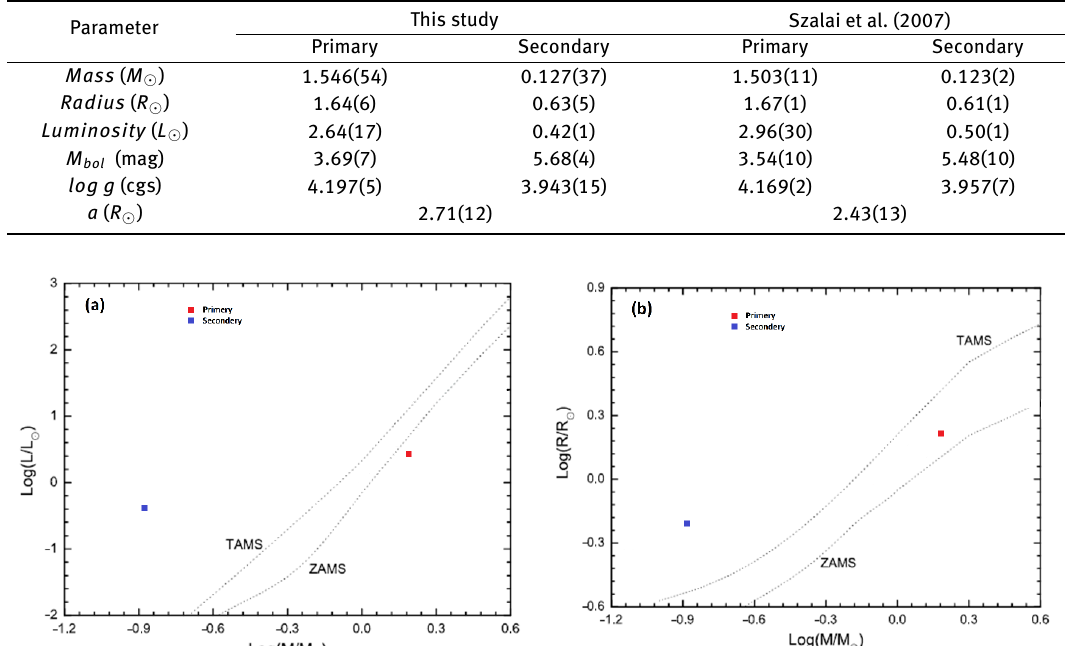
Table 5. Estimated absolute elements of V870 Ara along with the results of Szalai et al. (2007).